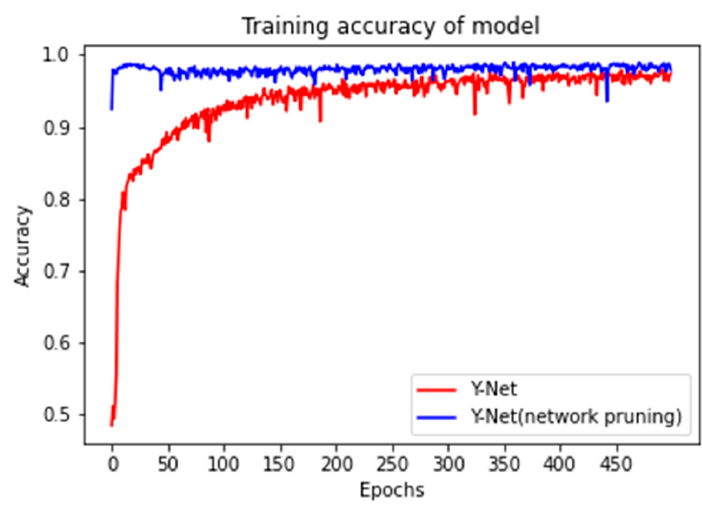
Figure 10. Accuracy of Y–Net before and after pruning. Table 3. The results of network pruning.